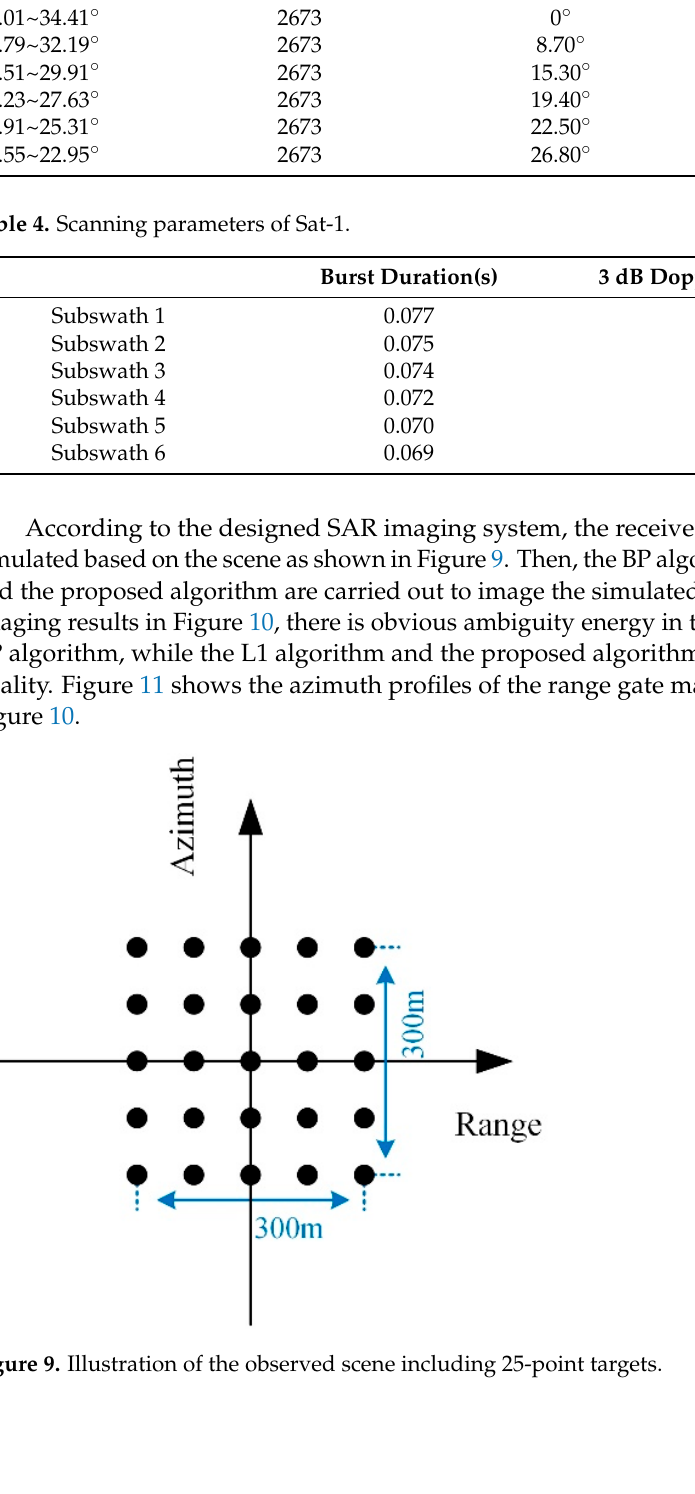
( c ) Figure 10. Illustration of the imaging results, where ( a – c ) are the results of the BP algorithm, the L1 algorithm, and the proposed algorithm, respectively. Figure 11. Illustration of the azimuth profile. Then, the azimuth resolution, the peak side lobe ratio, the integrated side lobe ratio, and the structure similarity are used to measure the performance of the three algorithms. The evaluated results are shown in Table 5.